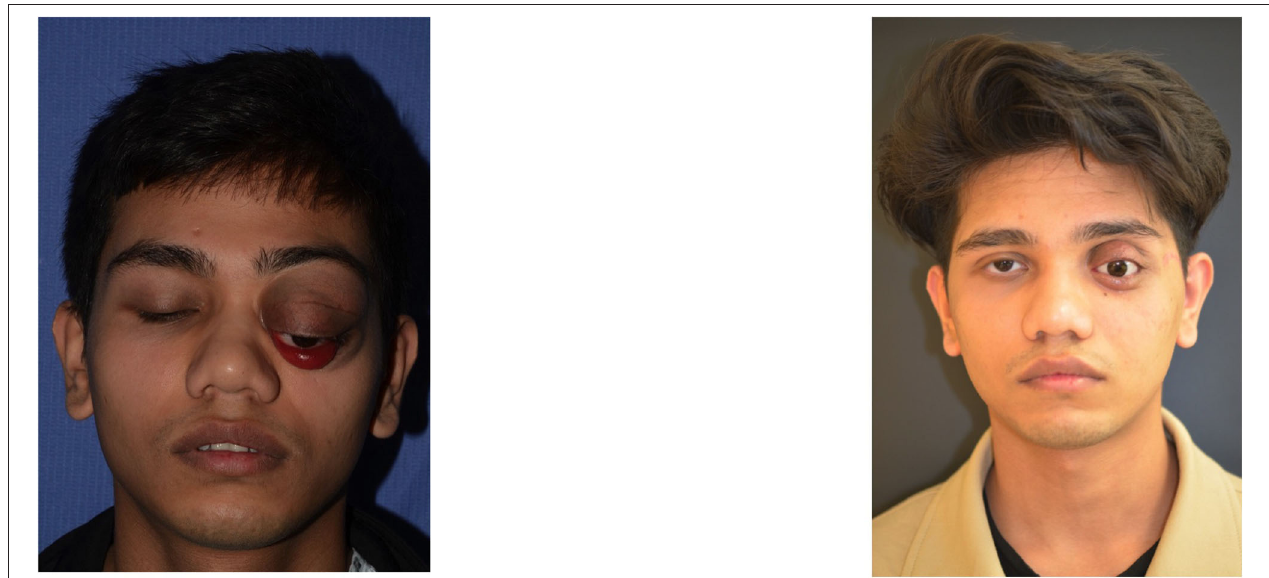
FIGURE 6 | We obtain a good orbital rehabilitation with an adequate prosthetic cavity, a good volume recovery, and therefore a satisfactory facial